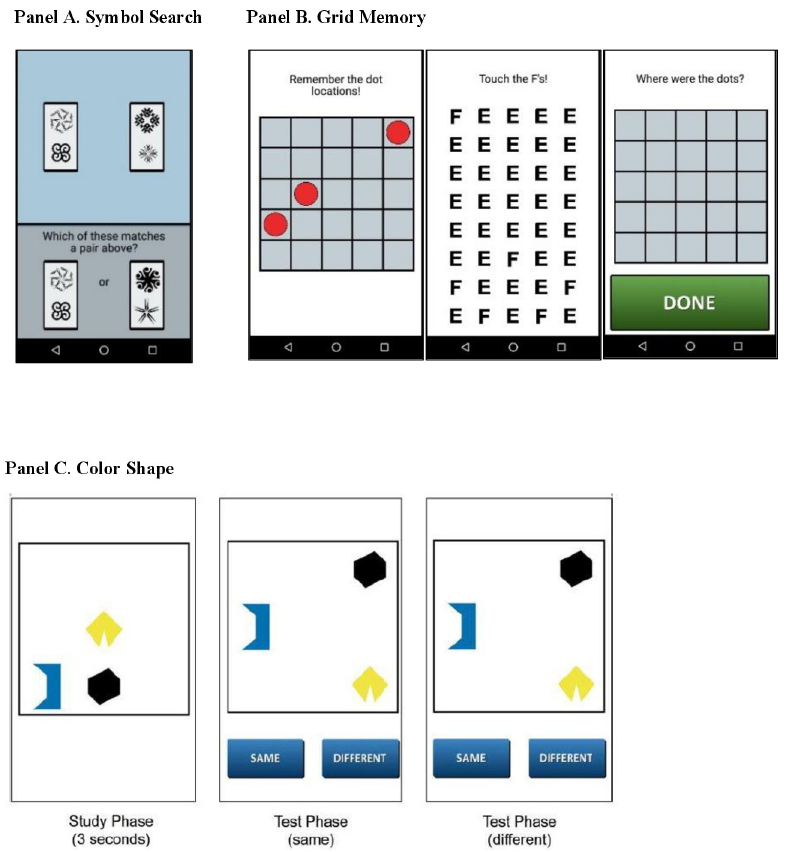
Fig 1. Mobile cognitive tests (panel A: symbol search; panel B: grid memory; panel C: color shape).